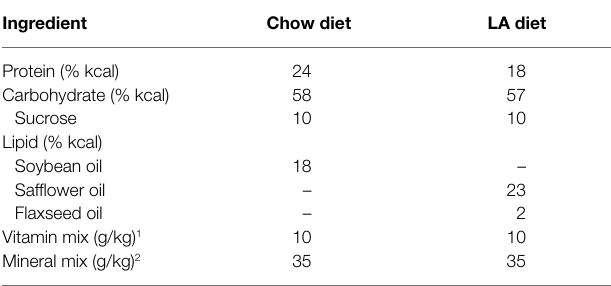
TABLE 1 | Nutrient content of the diets. Ingredient Chow diet LA